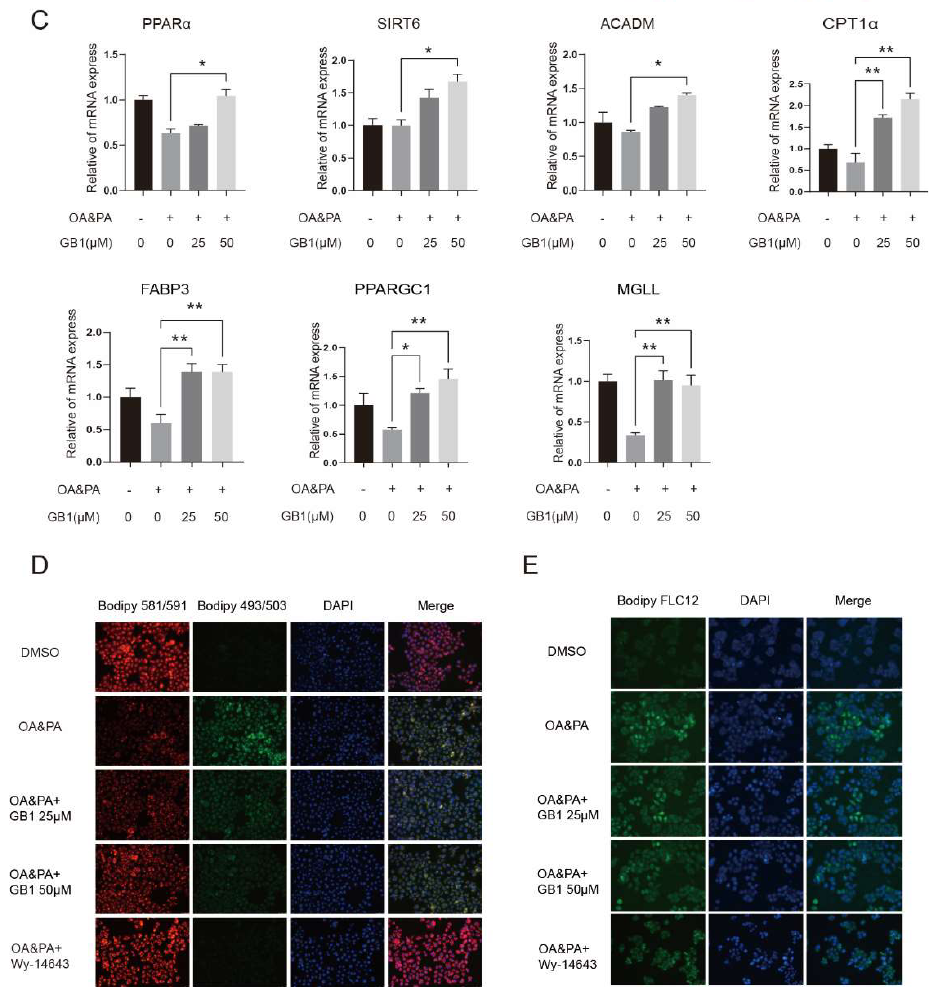
Figure 2. GB1 positively regulates lipid metabolism. ( A ) Western blot and ( B ) immunofluorescence staining assays revealed upregulation of the protein levels of PPAR α and SIRT6 in HepG2 cells undergoing OA&PA culture after GB1 treatment. ( C ) Changes in mRNA levels of PPAR α and SIRT6 after GB1 treatment. GB1 advanced lipid oxidization ( D ) and reduced the level of free fatty acids ( E ) in liver cells (200 × ). All data were presented as mean ± SEM of three independent experiments. *, p < 0.05, **, p <